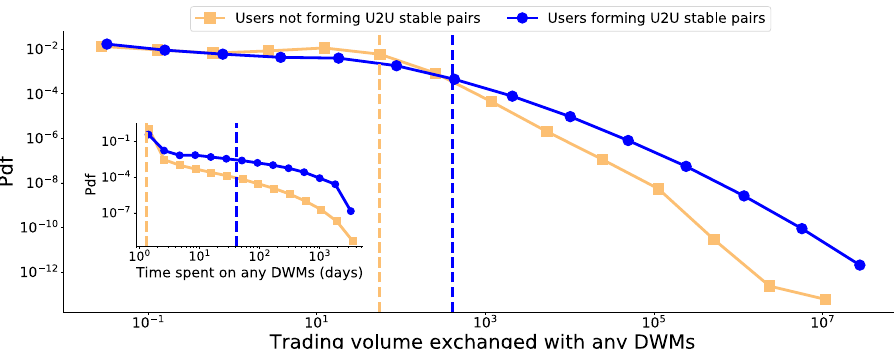
Figure 3. Role of users forming stable U2U pairs. (Main) PDFs of trading volume that users exchange with any DWMs. (Inset) PDFs of time spent by users on any DWMs. These distributions are explored for each of the 40 DWMs under consideration in Figure S5 and S6, respectively. Vertical lines represent median values of the respective distributions.